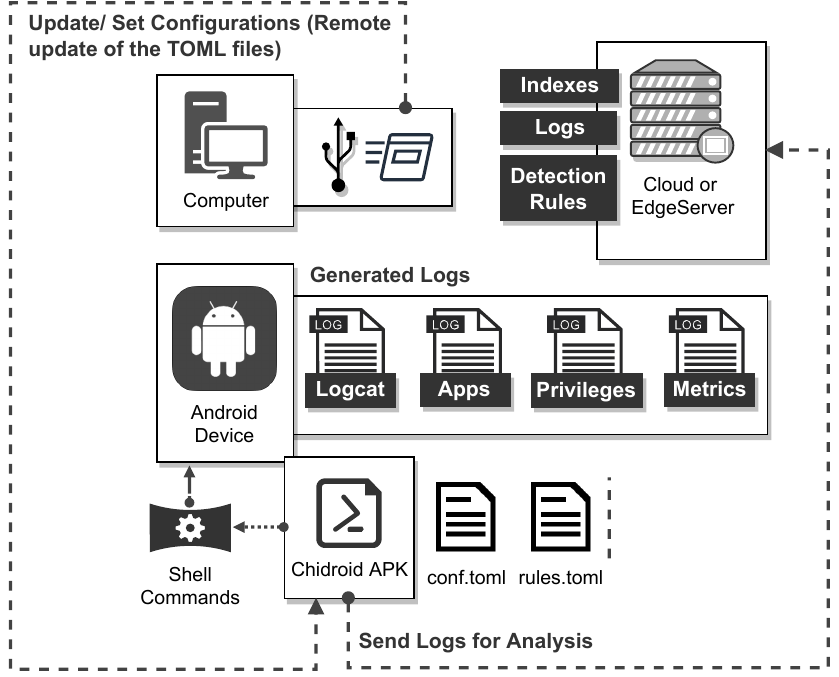
Figure 2. Chidroid architecture and deployment